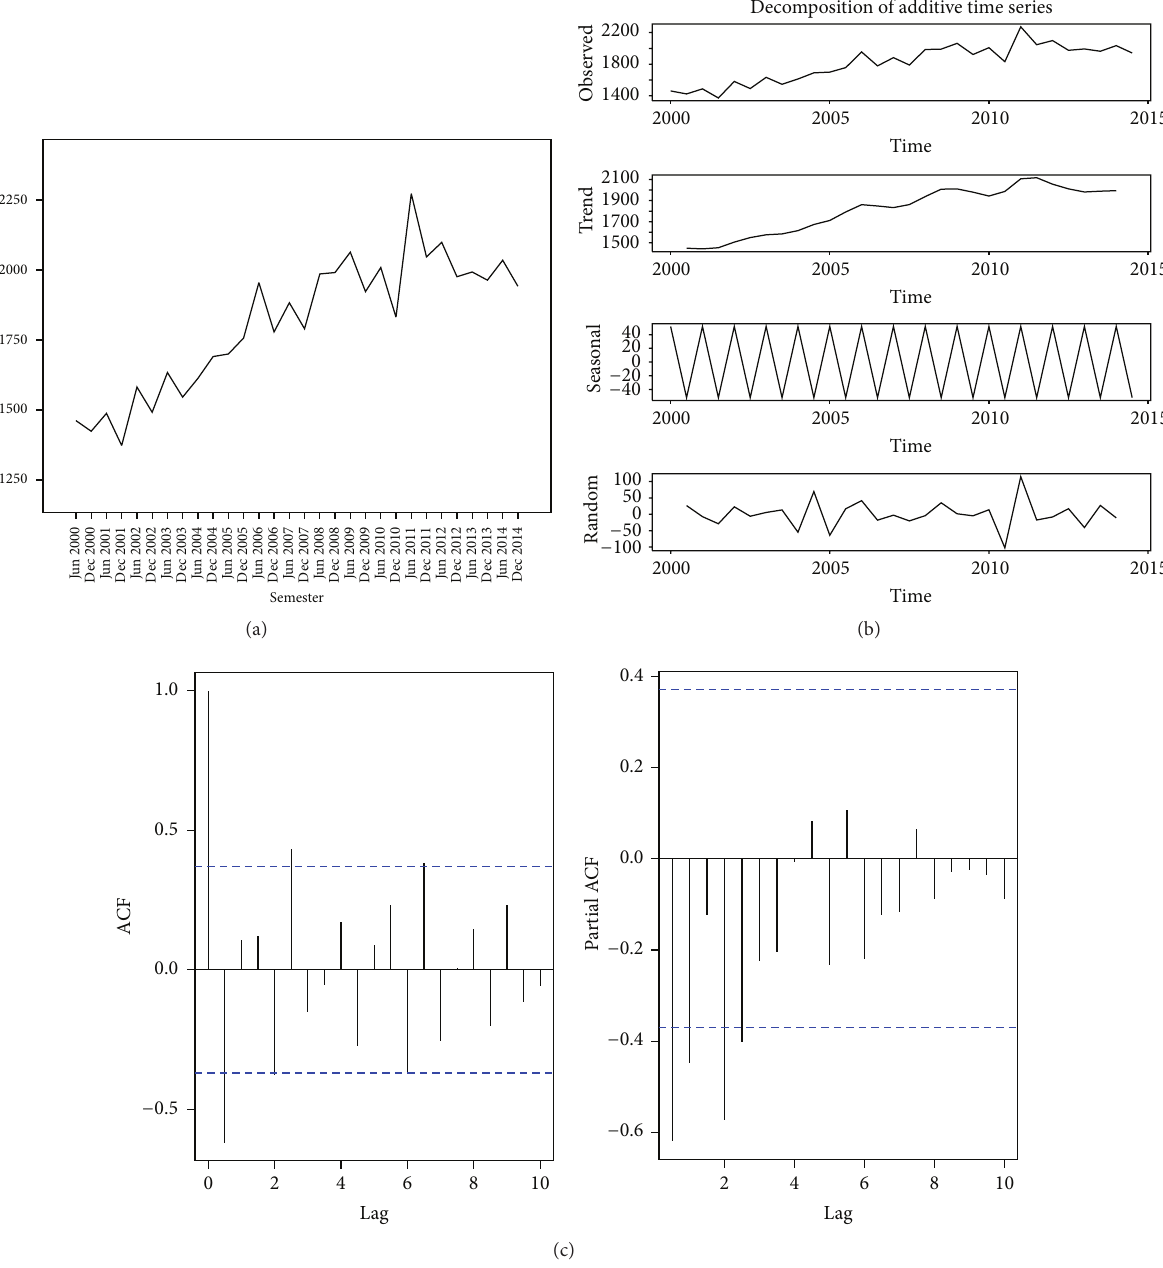
Figure 4: Time series analysis of all tuberculosis cases diagnosed, 2000–2014, Benin. (a) Tuberculosis cases diagnosed per semester; (b) decomposition of tuberculosis cases diagnosed with an additive model; (c) Autocorrelation and Partial Autocorrelation Functions of tuberculosis time